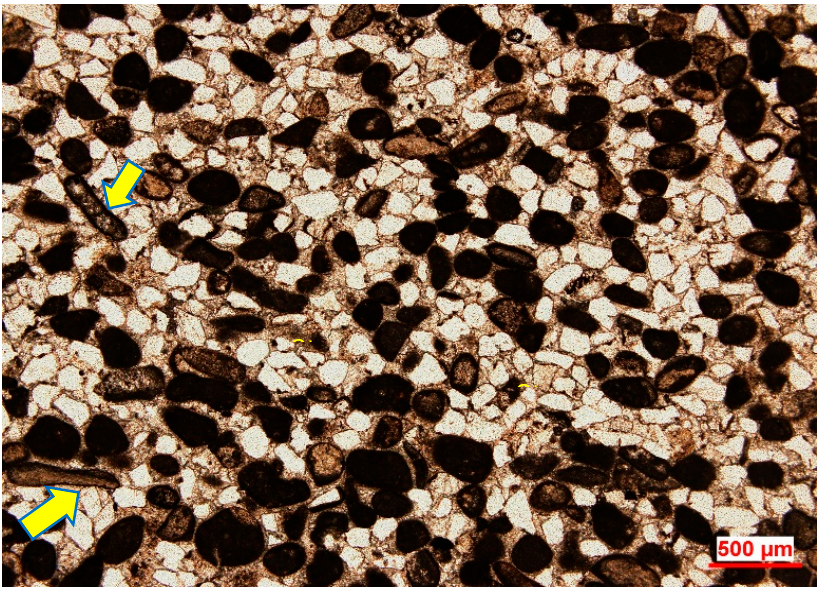
Figure 4. Quartz-rich peloidal packstone with some skeletal fragments (yellow arrows). Quartz grains range in size between 30 to 200 microns. Scale bar at bottom right.